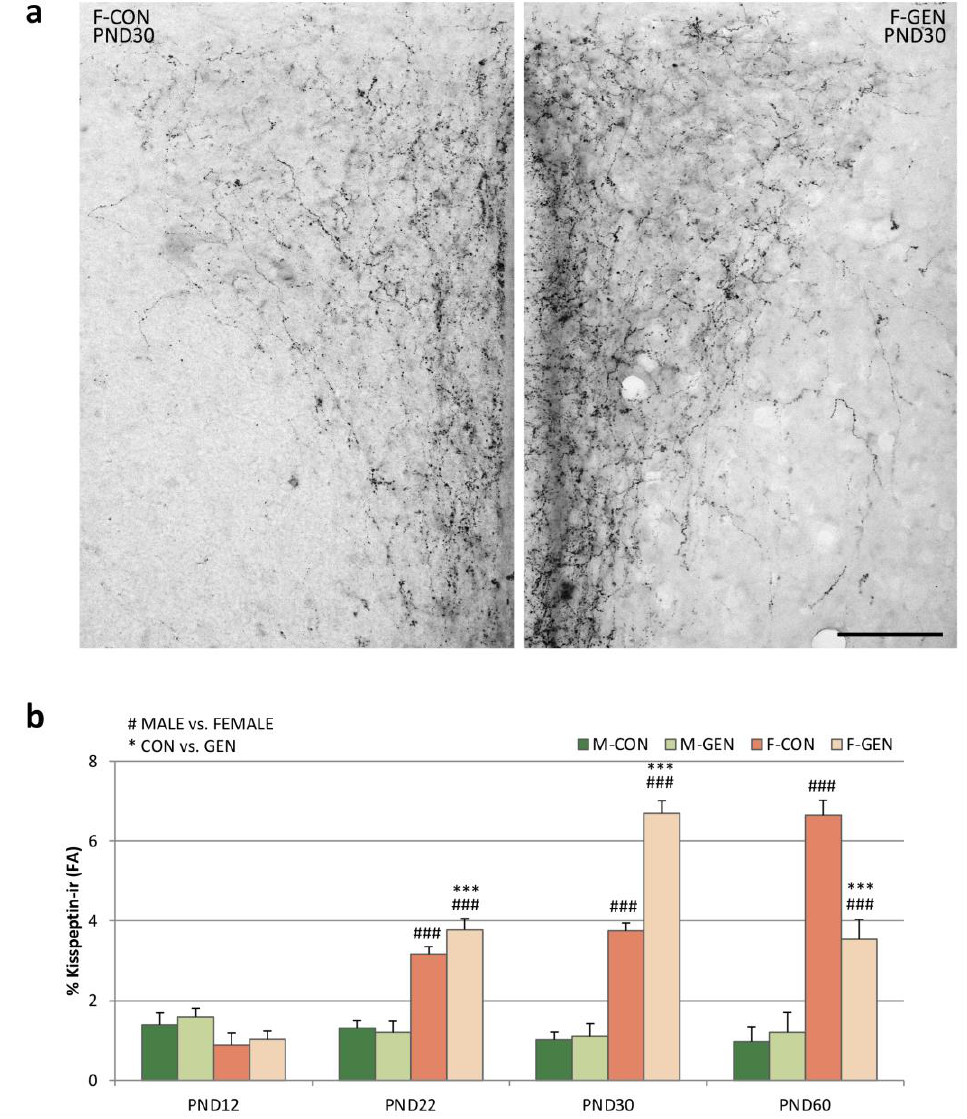
Figure 6. Kisspeptin innervation of the PVN. ( a ) Comparison of the PVN innervation at PND30, when the F-GEN group has its peak. ( b ) Variations of the fractional area (FA; mean ± SEM) covered by kisspeptin immunoreactive fibers in the PVN of both sexes (M-CON, M-GEN, F-CON, and F-GEN) at different ages (PND12, PND22, PND30, and PND60). Scale bar = 100 µm. *** p ≤ 0.001; ### p ≤ 0.001 (Bonferroni test)